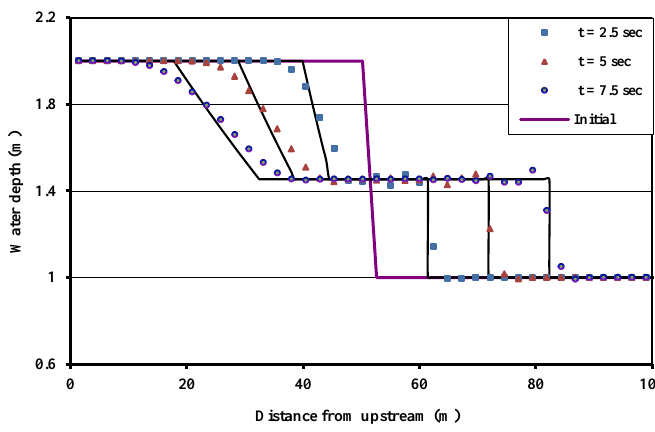
Figure 2. Comparison of the model results with the analytical solution for dam break